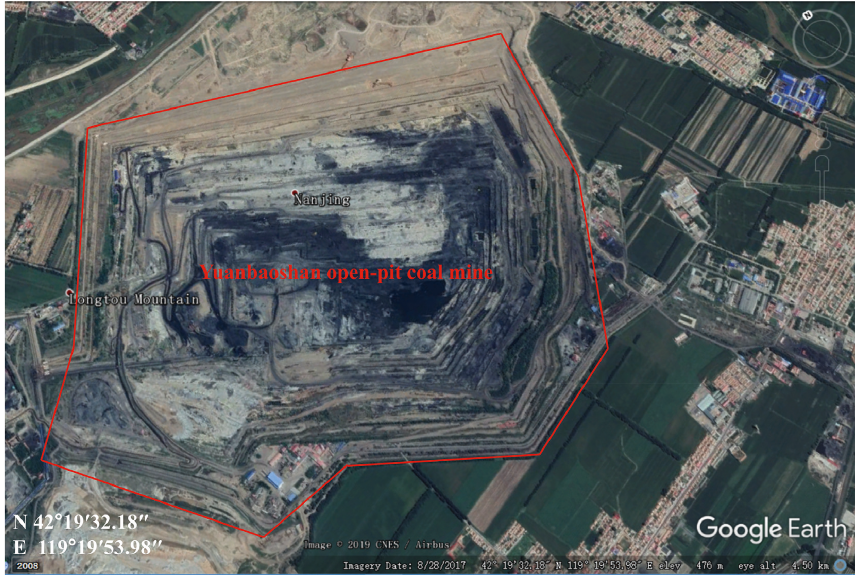
Figure 1: Location of Yuanbaoshan open-pit coal mine.